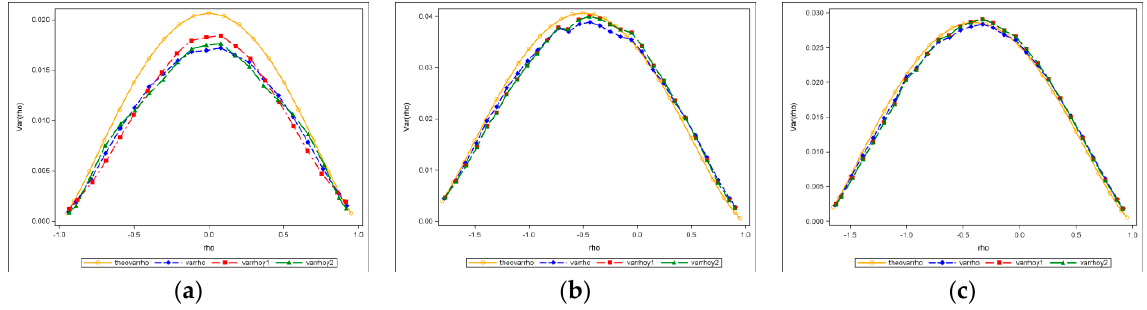
Figure 5. Variance comparison plots for 10-by-10 ( 𝑛 = 100 ) tessellations: ( a ) square rook case; ( b ) square queen case; ( c ) hexagonal case.